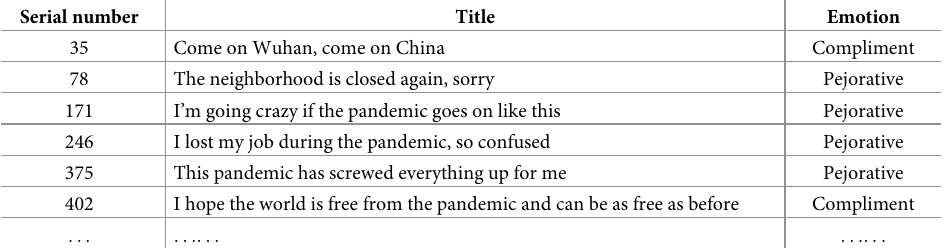
Table 5. Cases of emotional expression user participation in the "Lilac Forum" during the